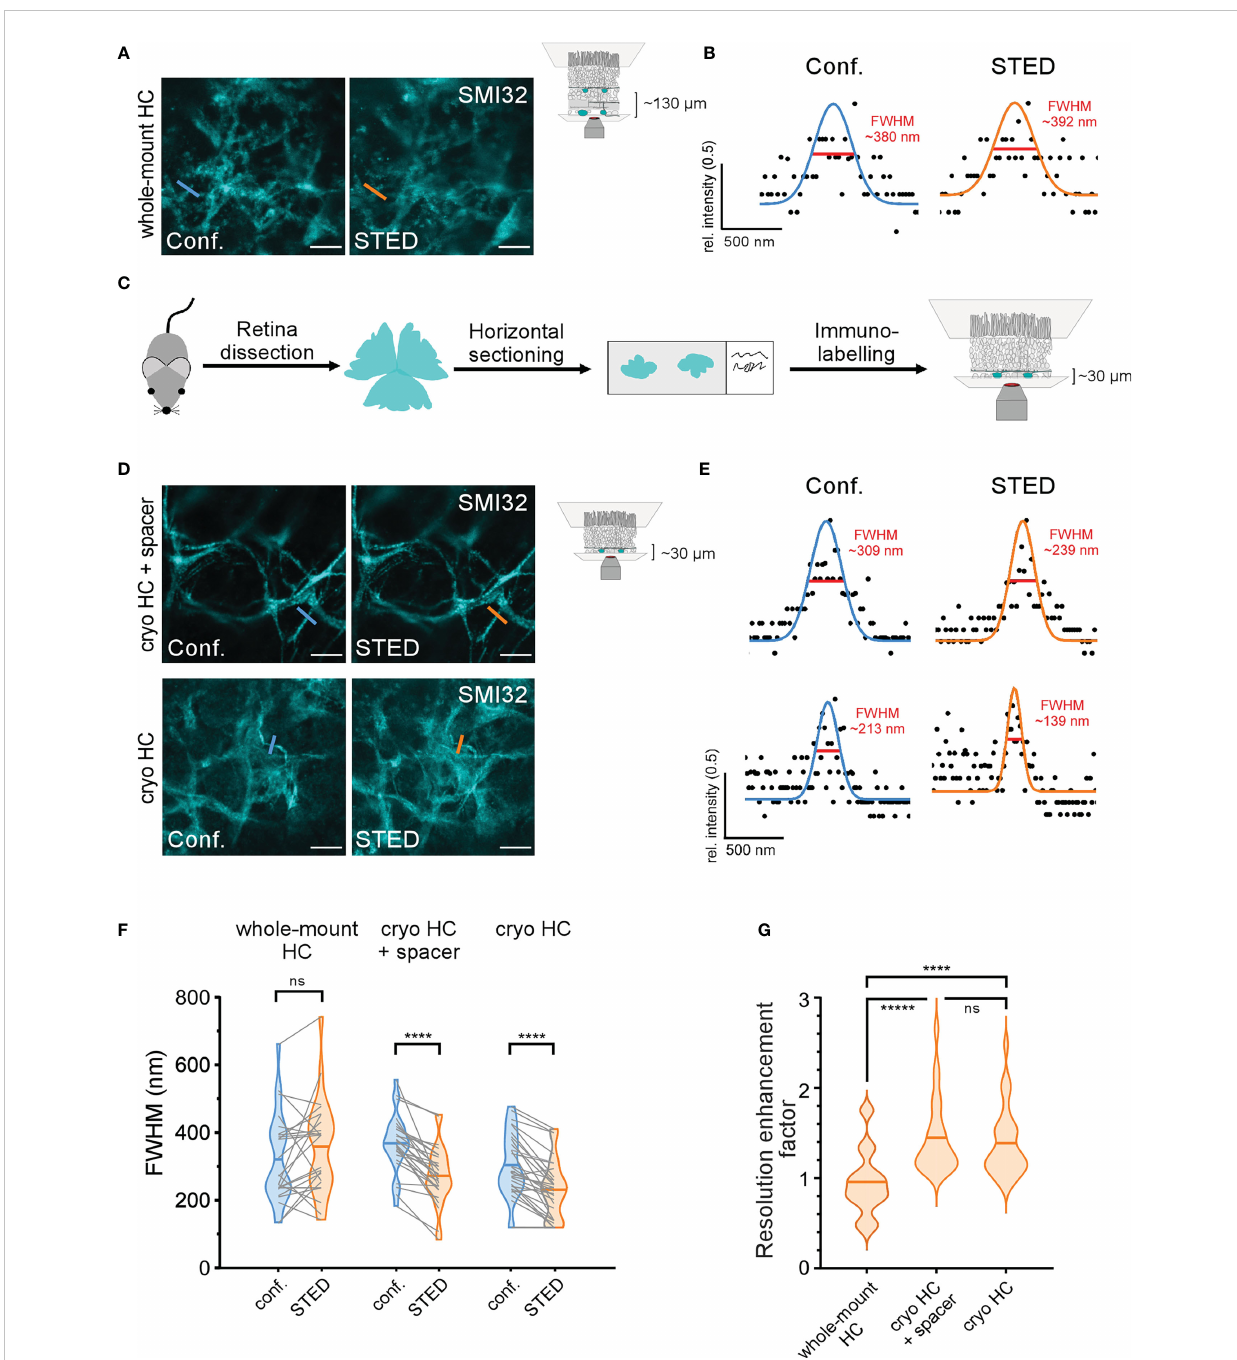
FIGURE 6 STED imaging of horizontal cell structures in the outer retina (A) Comparison of confocal (left) and STED (right) images of SMI32-stained HC axon terminals at a depth of ~130 µm in the retinal whole-mount imaged through the inner retina. Each image was fi rst taken in confocal mode and then in the STED mode to allow a direct comparison. (B) Confocal (blue) and STED (orange) FWHMs of the same neuritic structure as indicated in (A) , (C) Scheme of alternative experimental design for imaging structures in the deeper outer retina. Retinae were horizontally cryosectioned, mounted on glass slides, immunolabelled, and imaged. (D) Example confocal and STED images of SMI32-stained HC axonal structures taken with (top) and without (bottom) silicon spacers between slide and coverslip. (E) Confocal and STED FWHMs of the same neuritic structures in (D) , (F) Quanti fi cation of FWHMs of corresponding HC structures in confocal (blue) and STED (orange) imaging mode for whole-mount condition (whole-mount HC) and horizontally cryosectioned retina (cryo HC) with and without spacers (whole-mount HC n = 1 animal/24 structures, Cryo HC + spacer n = 1 animal/26 structures, Cryo HC n = 1 animal/30 structures, p< 0.0001 = ****, ns = not signi fi cant, paired t-tests, horizontal bars indicate means, grey lines connect corresponding values). (G) Violin plot showing the resolution enhancement factor calculated as the ratio of the corresponding FWHMs in confocal and STED images for the three experimental conditions, horizontal bars indicate means (p< 0.0001 = ****, p< 0.00001 = *****, ns = not signi fi cant, Wilcoxon rank sum test). For A and D, the excitation wavelength was 532 nm, and the dye was ATTO532. Scale bars: 5 µm in